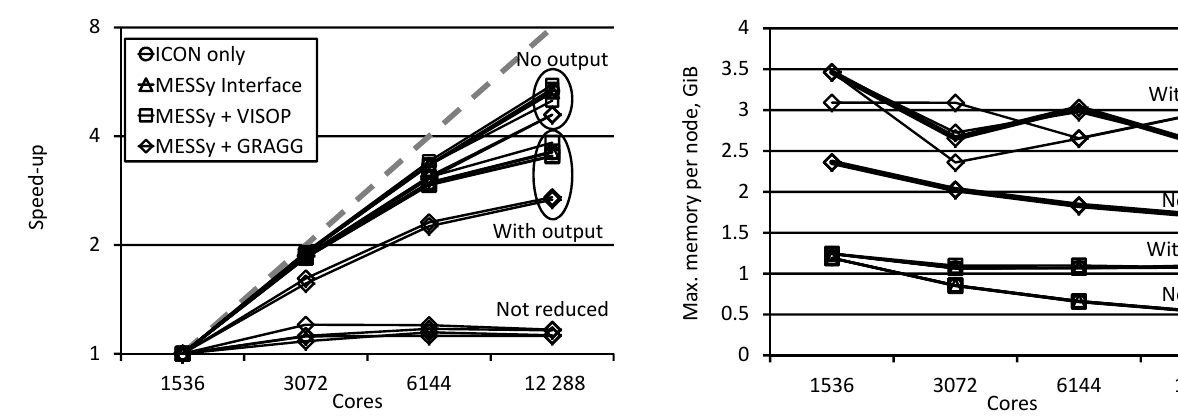
Figure 10. Maximum of memory consumption per node. Symbols as in Fig.